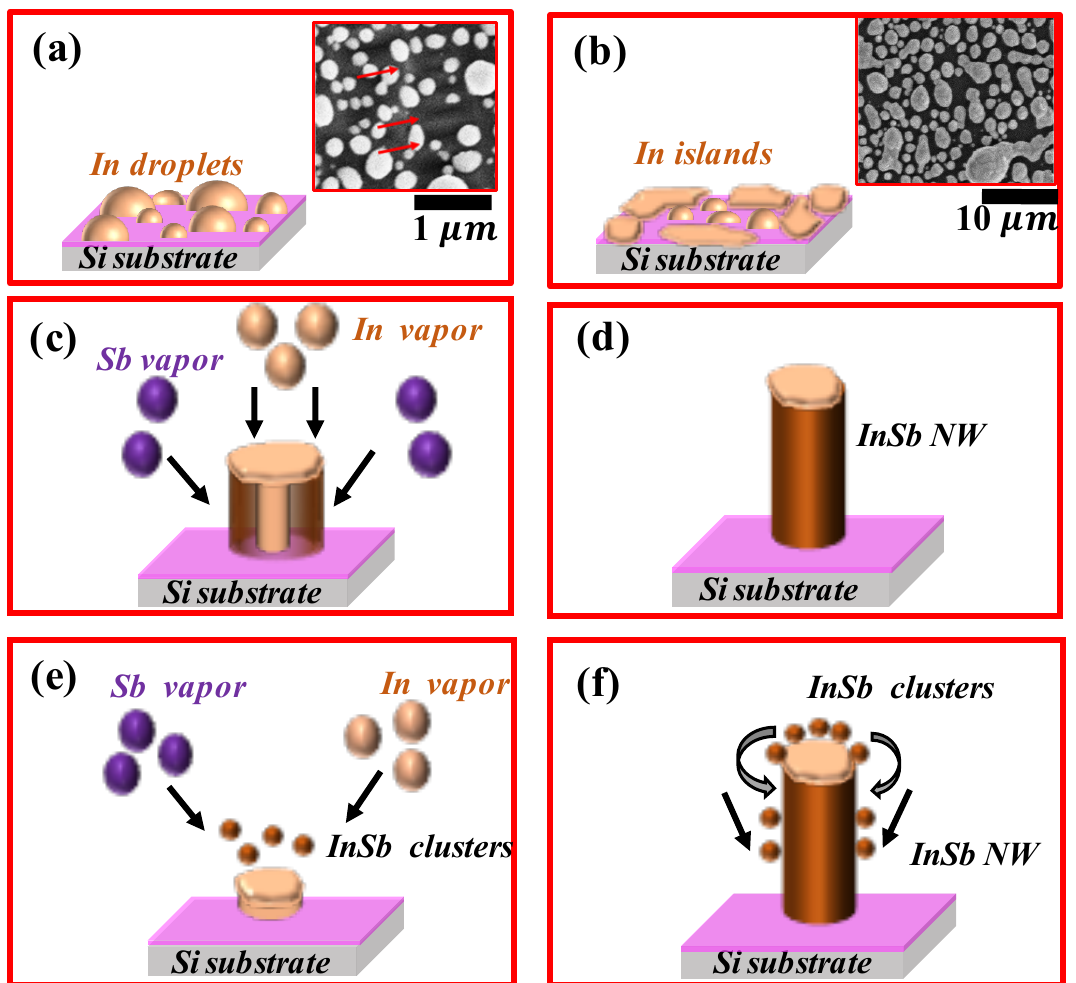
Figure 3. Schematic of the two possible growth mechanism of a - InSb NWs. ( a ) Initiation of NW growth as a result of In droplets forming on the Si substrate. These droplets have different sizes as shown in the inset; ( b ) As temperature rises at a very high rate, the droplets coalesce into islands and migrate to the edge of the Si substrate. Smaller In droplets are left behind at the center of the Si substrate; inset shows In islands coalescing and ripening; ( c , d ) Possible growth mechanism 1, in which an In core first precipitates from the molten seed ( c ), followed by complete antimonidization of the In core, resulting in an InSb NW ( d ); ( e , f ) Possible growth mechanism 2, in which In and Sb atoms combine to form InSb clusters over the molten In droplet ( e ). These clusters settle on the surface of the molten droplet and slips to the lower hemisphere and diffuses to the interface between the substrate and the molten In droplet ( f ). The mechanisms follow those reported for the growth of a-SiO x NWs [28]. Another significant feature of some of the NWs is shown in Figure 4a, where metallic In precipitates out of the growing NW and is present as ‘nodules’ on the edge of the NW. As seen in the EDX spectrum (Figure 4b), these nodules are pure In . Such precipitates of the metal catalyst along the NW edges have been reported by other groups. Their appearance is attributed to evaporation of the element In from the source and subsequent condensation along the NW edges, following the mechanism discussed in Refs.